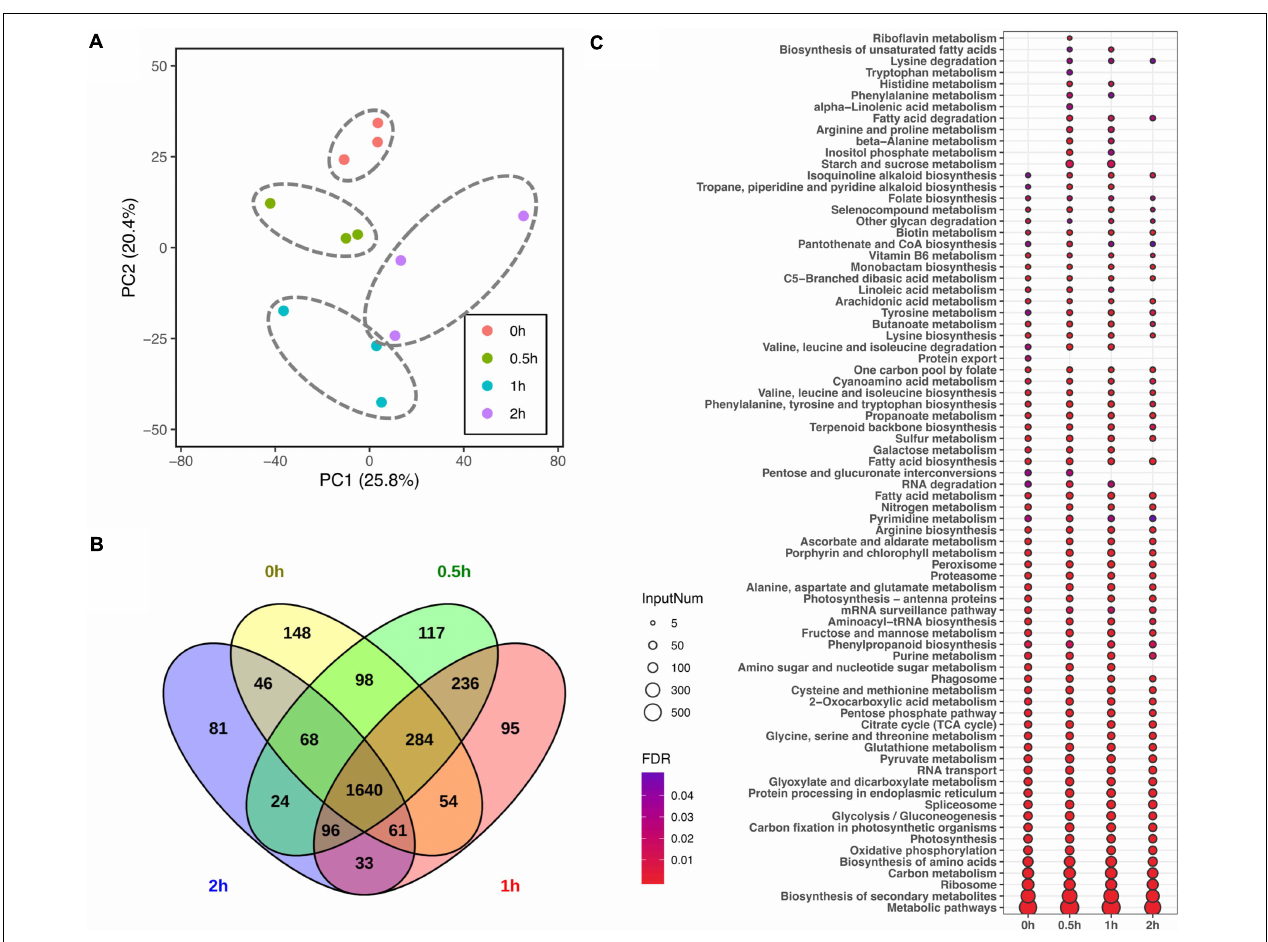
FIGURE 2 | Impact of salt treatment for 0, 0.5, 1, and 2 h on leaf proteome of soybean ( Glycine max [L.] Merr.) accession C08. Total leaf protein was extracted and analyzed by tandem mass spectrometry from 14-day-old C08 seedlings grown in 1/2 strength Hoagland solution and treated with or without 0.9% (w/v) NaCl. (A) PCA of proteome profiles. Normalized protein abundance was Log 2 transformed and used as input data, centring and scaling was performed prior than calculating principle components. The first and second principal components were visualized in dot plot, and the variation was labeled in the brackets. (B) Venn diagram of identified proteins in each time point. (C) Kyoto Encyclopedia of Genes and Genomes (KEGG) analysis of identified proteins from each time point. The color gradient represents the value of a false discovery rate, with a cut-off ≤ 0.05. The size of each circle represents the input number of proteins in the enriched pathway. The protein lists of enriched pathways are provided in Supplementary Table 4